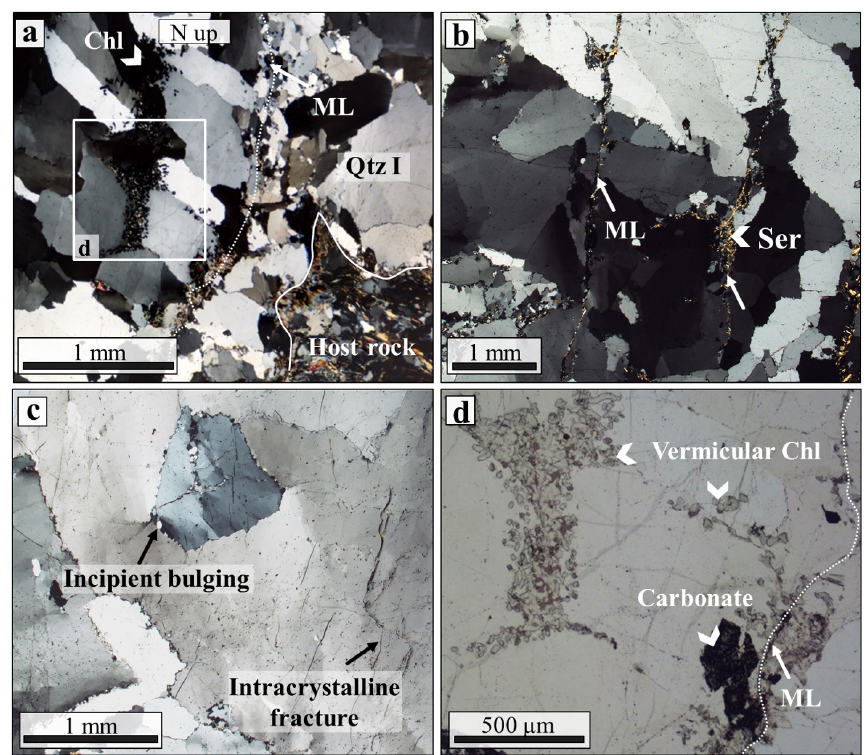
Figure 5. Microtextural characteristics of Qtz I from the damage zone of BFZ300 (samples PH21 and TPH-120-2). (a) Stitched micropho- tographs of a Qtz I vein showing elongated–blocky texture with crystals growing obliquely with respect to the vein boundaries, which suggests growth under oblique dilatation. A series of median lines (MLs) are marked by (b) sericite crystals suggesting repeated crack and seal. Quartz crystals show low-temperature crystal–plastic deformation by undulose extinction and extinction bands. (c) Detail of plastic deformation in damage zone quartz veins: distorted crystals showing incipient bulging and intracrystalline fracturing. (d) Detail (plane-polarized light) of an ML and secondary fractures both decorated by vermicular chlorite and aggregates of rare-earth-element-bearing